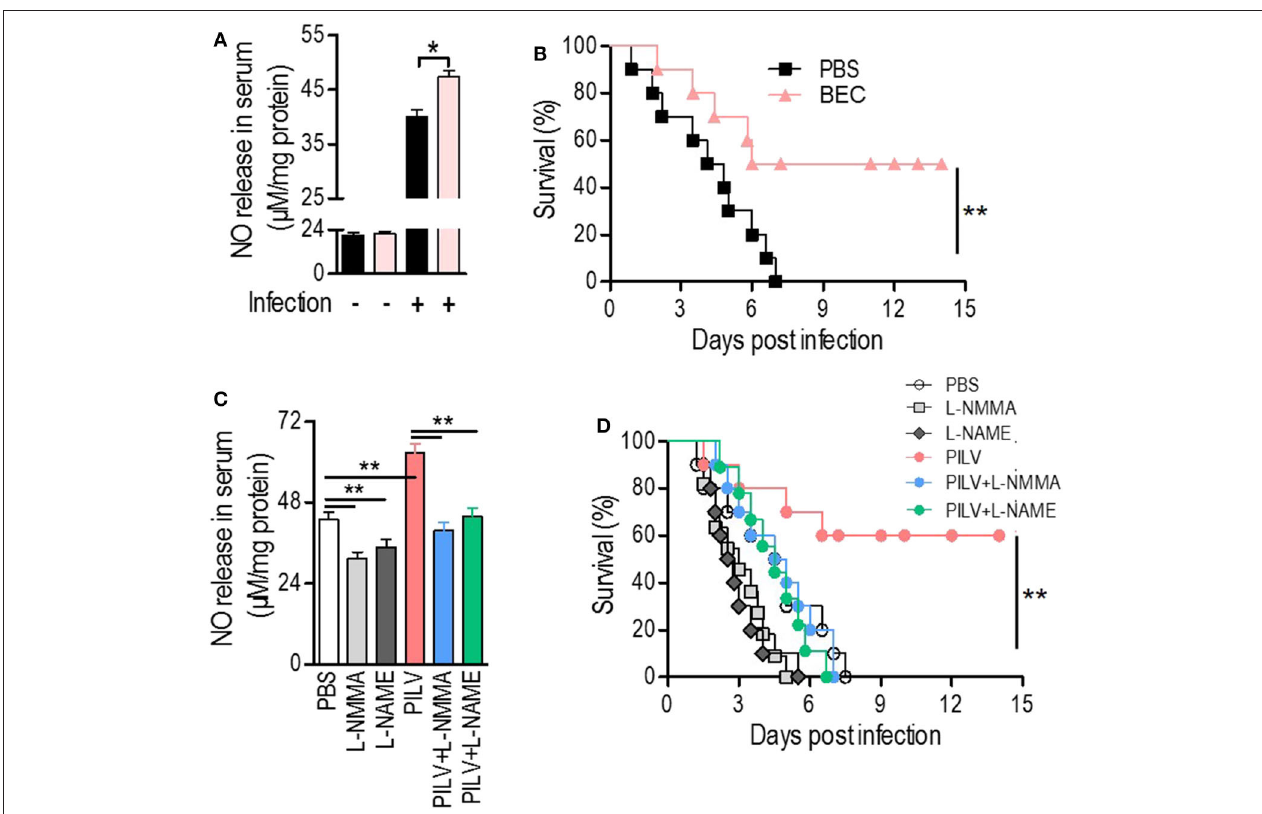
FIGURE 5 | Metabolite-induced NO confers protection against staphylococcal infection. (A,B) The impact of a competitive arginase inhibitor, BEC (S-(2-boronoethyl)-L-cysteine), on NO release in serum (A) and survival (B) of mice under a lethal bloodstream infection with S. aureus USA300. (C,D) The impact of NO inhibitors, L-NMMA, and L-NAME, on NO release in serum (C) and survival (D) of mice under a lethal bloodstream infection with S. aureus USA300. Six hours after the injection of BEC (50mg kg − 1 ), L-NMMA (40mg kg − 1 ), L-NAME (40mg kg − 1 ), PILV, PILV plus L-NMMA (40mg kg − 1 ), or PILV plus L-NAME (40mg kg − 1 ), BALB/c mice ( n = 30) were lethally challenged by S. aureus USA300 and then divided into two subgroups. One subgroup ( n = 10) was used for NO measurement and another ( n = 20) was used for observing survival. Five of the survival mice were euthanized 3 days after the infection to measure NO and urea production in serum. Survival was monitored over 14 days. Data are represented as means ± SEM. * P < 0.05 and ** P < 0.01 (two-tailed Student’s t